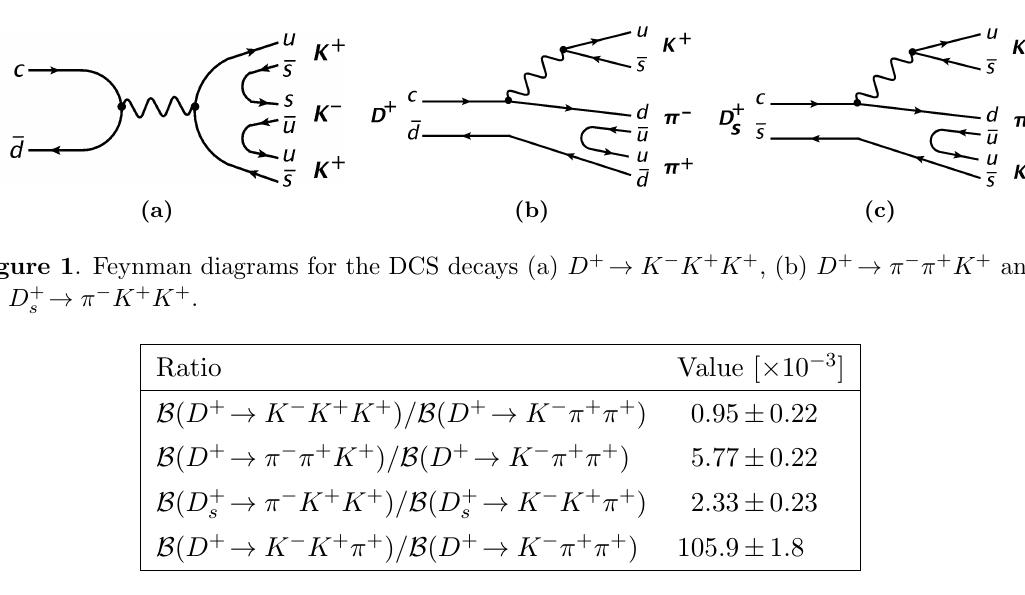
Table 1 . World averages for the branching-fractions ratios under consideration